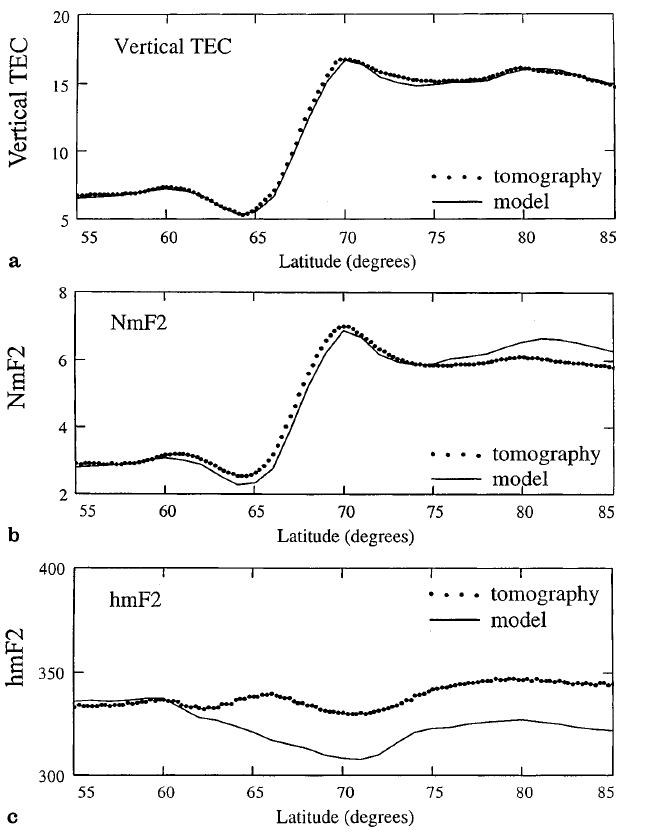
Fig. 4a–c. Comparisons of modelled ( solid lines ) and reconstructed ( dotted lines ) altitude profiles of electron density at latitudes of a 60 (cid:176) N, b 70 (cid:176) N and c 80